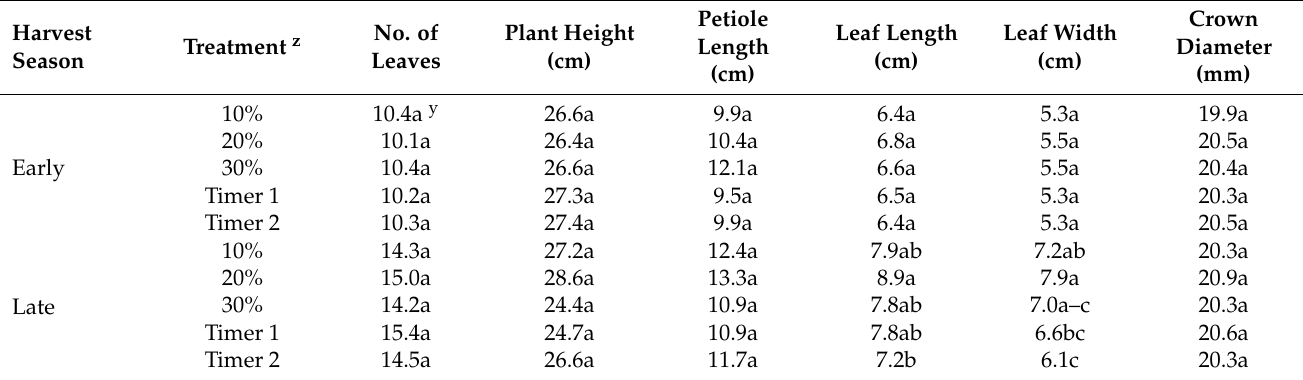
Table 1. Growth characteristics of strawberry ‘Kuemsil’ affected by the nutrient solution supplying system using different drainage rate levels and timings at 159 (early harvest season) and 218 (late harvest season) days after transplanting (Drainage rate 10%, 20%, or 30%; Timer 1, timer set for 4 applications daily; Timer 2, timer set for 6 applications